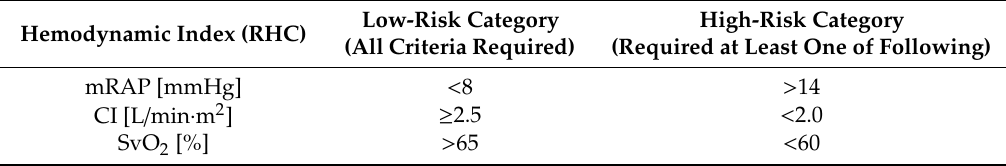
Table 1. The cut-o ff values of hemodynamic indices in the low-risk and high-risk categories. Low-Risk Category High-Risk Category Hemodynamic Index (RHC) (All Criteria Required) (Required at Least One of Following) mRAP [mmHg] < 8 > 14 CI [L / min · m 2 ] ≥ 2.5 < 2.0 SvO 2 [%] > 65 <